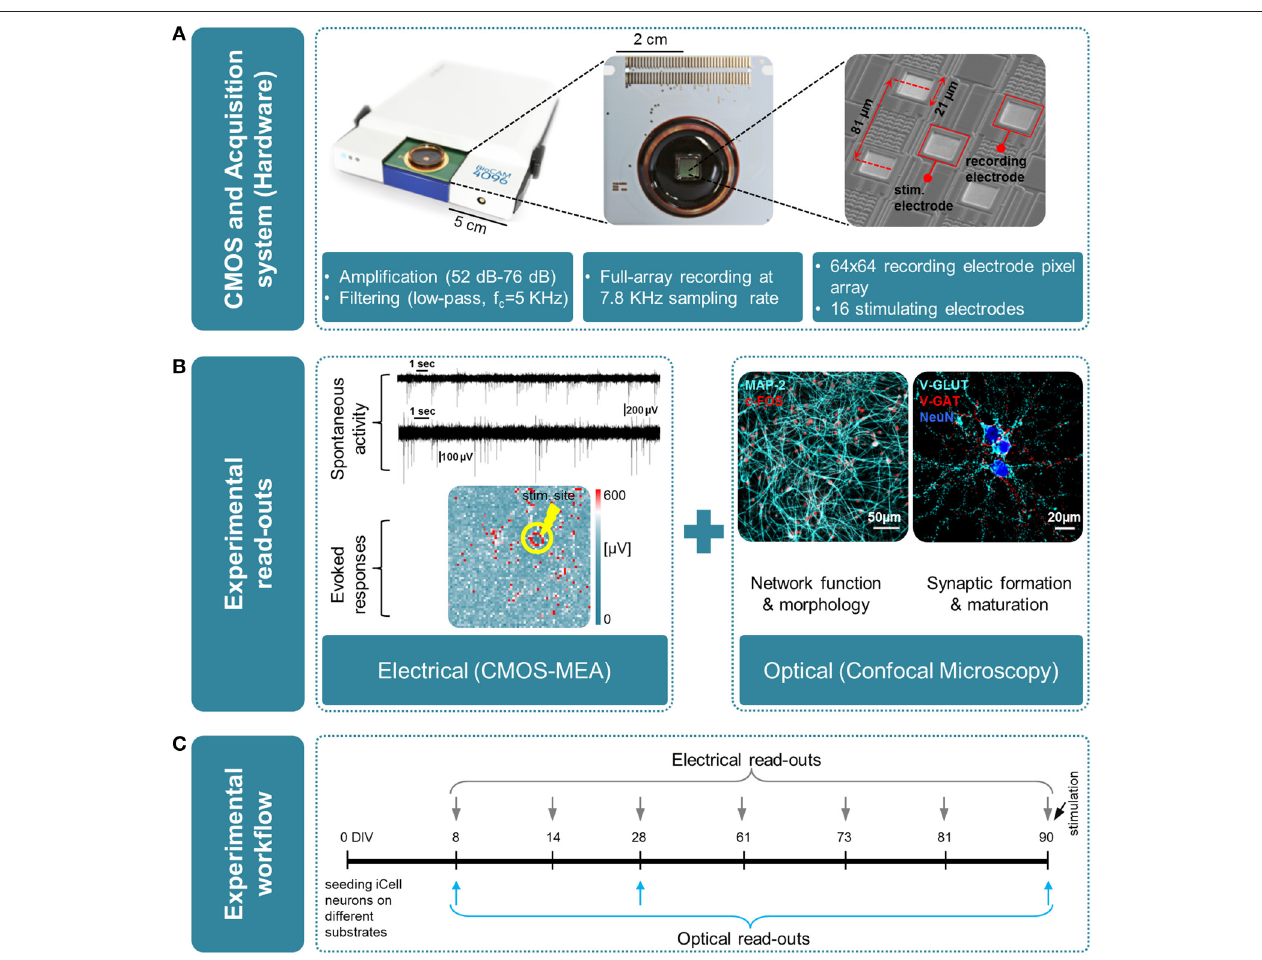
FIGURE 1 | Overview of the experimental platform used in this work for high-resolution electrical and optical read-outs. (A)(from left to right); Real-time hardware for electrophysiological recordings from CMOS multielectrode arrays (CMOS-MEAs); view of a CMOS-MEA that features on-chip recording and stimulation electrodes (3Brain GmbH, Switzerland); scanning electron microscope (SEM) image of an area of the electrode array, with recording and stimulating electrodes. (B) Overview of the experimental read-outs used in this work, combining optical and electrical measures, i.e., left: electrical using CMOS-MEA; right: optical by means of confocal microscopy. (C) Time line of the experiment and time-points for optical and electrical